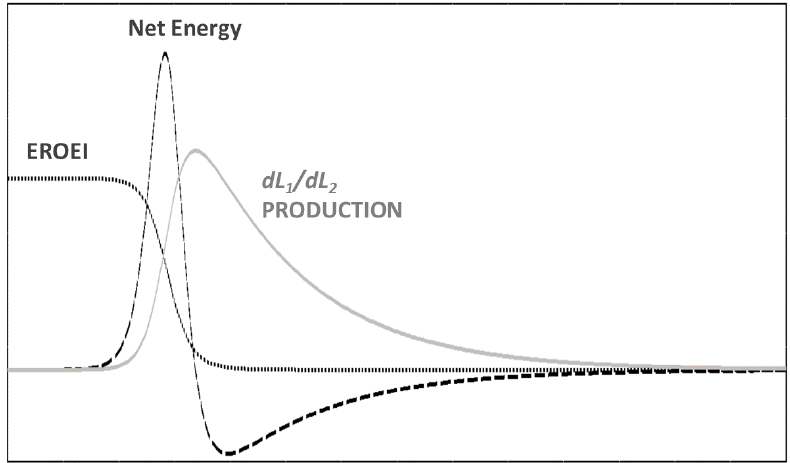
Figure 5. Behavior of the EROEI SCLV and Net Energy according to the SCLV